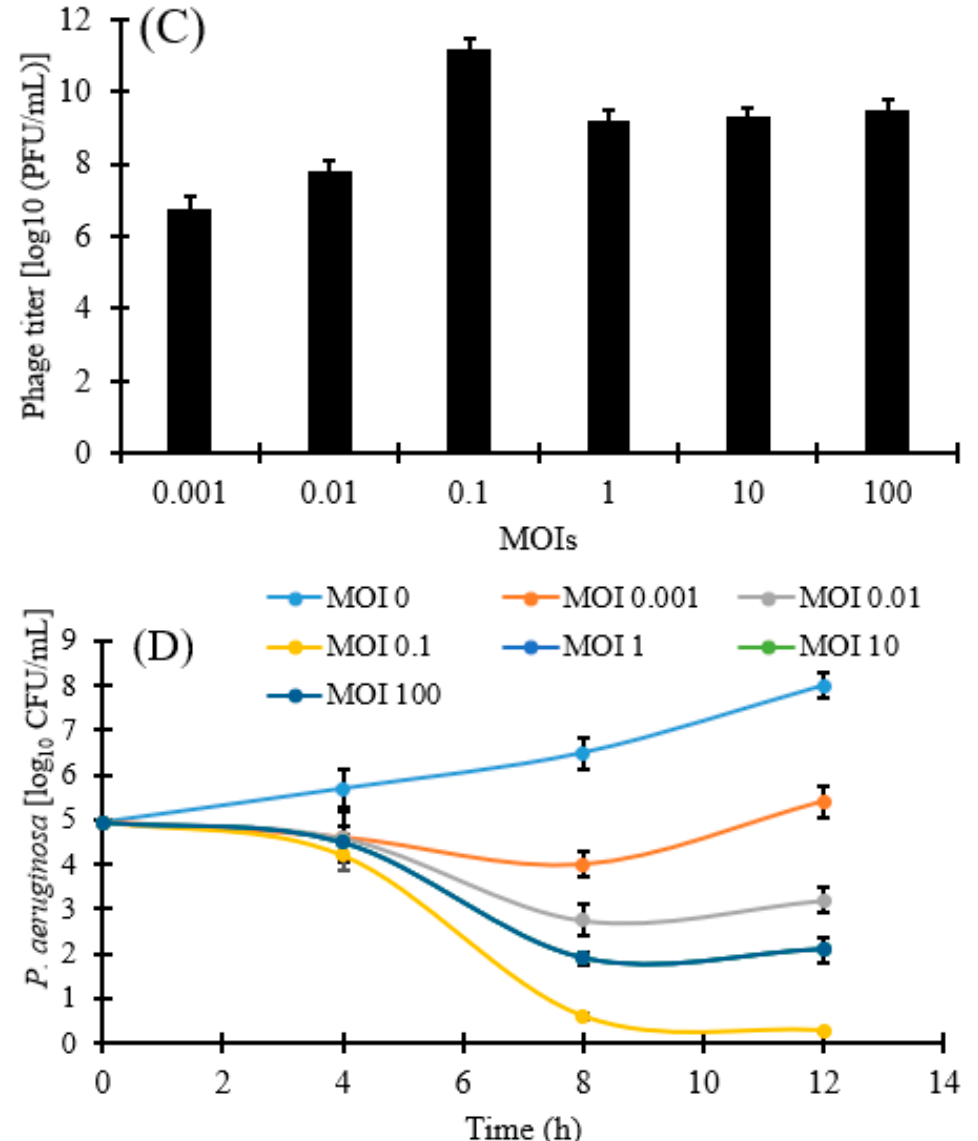
Figure 4. ( A ) Stability of vB_PseuP-SA22 under thermal treatment; ( B ) pH stability of vB_PseuP- SA22; ( C ) Determination of optimal MOI; and ( D ) Lysis kinetics. Error bars represent mean value ± SD. Two-way ANOVA and the Bonferroni post-hoc test were conducted using the GraphPad Prism software. Significant statistical differences were noted between the control and the respective phage-treated samples at different MOIs ( p <